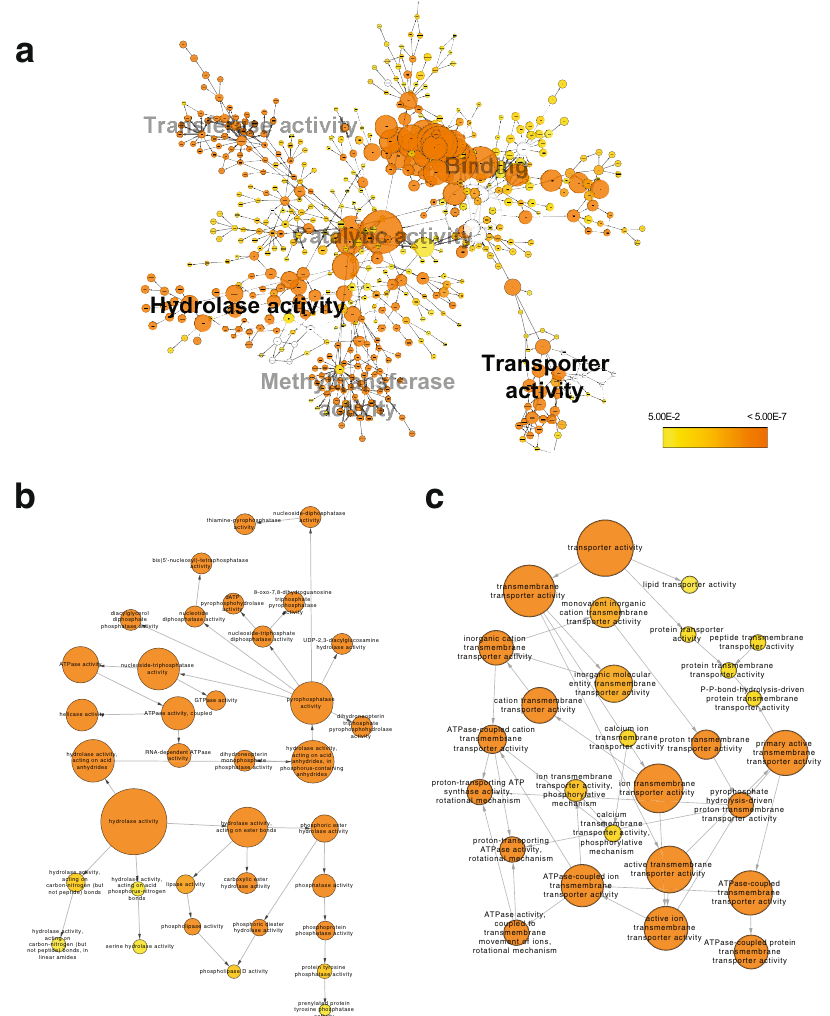
Fig. 5 Network of enriched Gene ontology (GO) molecular function categories of commonly methylated 6mA ApT genes in R. irregularis isolates C2/C5 and C3. a General overview of the six principal enriched clusters of molecular function with the hydrolase activity and transporter activity clusters highlighted in bold. b Hydrolase activity cluster shown in greater detail. c Transporter activity cluster shown in greater detail. The diameter of the circle refers to a number of genes per GO term (which is shown in Supplementary Data 1) and the color of the circle refers to the FDR corrected probability ( P ), where the yellow to orange gradient represents increasing signi fi cance (Supplementary Data